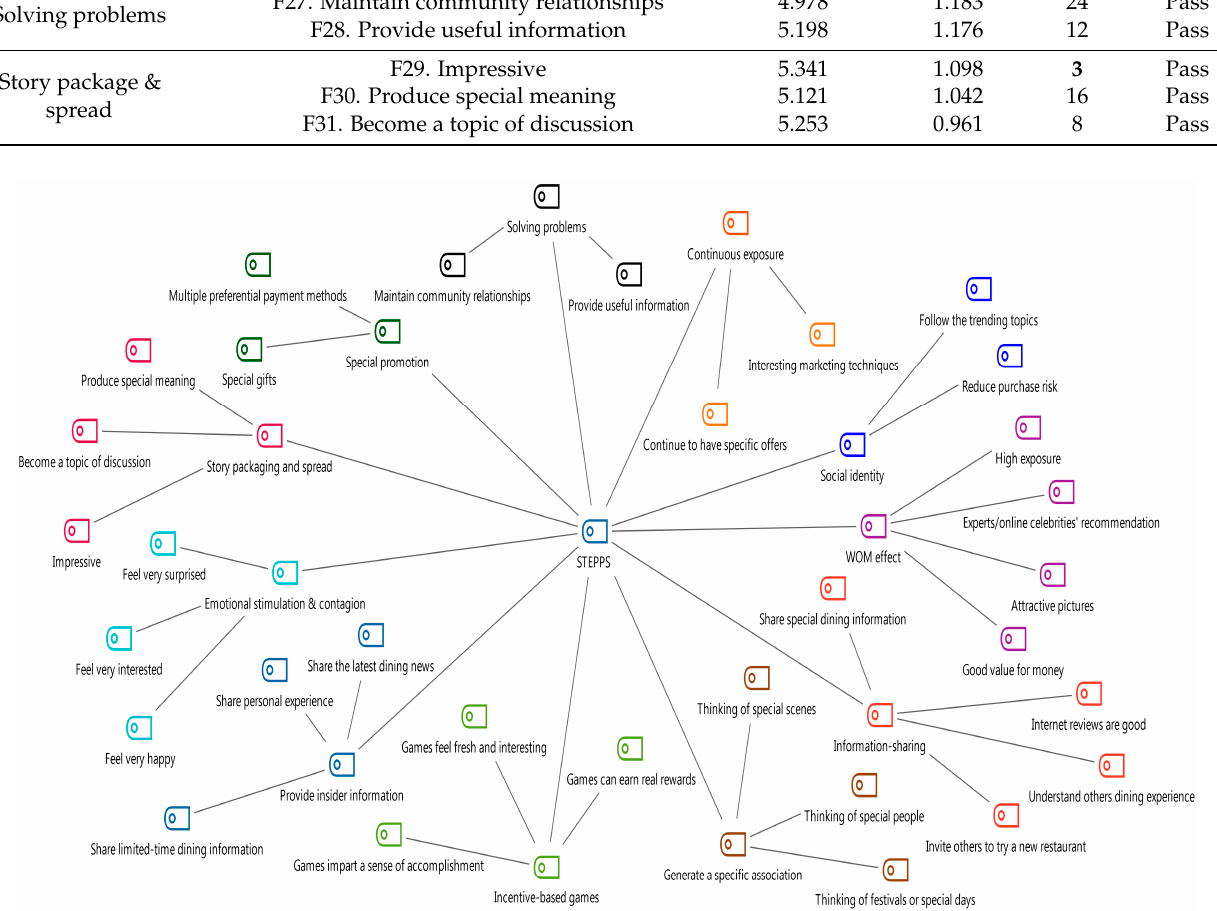
Figure 2. Enablers identified in the content analysis. Table 2. Scores and ranking of the enablers.